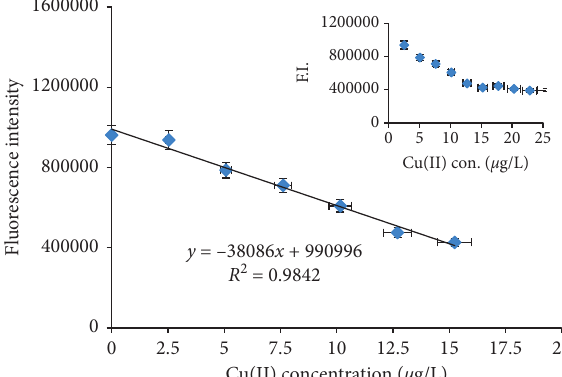
Figure 5: The change in the fluorescence spectra of L with the increasing Cu 2+ ion concentration (from 0 to 30 μ g/L) in aceto- nitrile-water (1:1). Inset: the molar ratio graph plotted from the change in the fluorescence at 360nm. L : 2.0 × 10 − 7 M. y = 5 E – 07 x – 0.162 R 2 = 0.9938